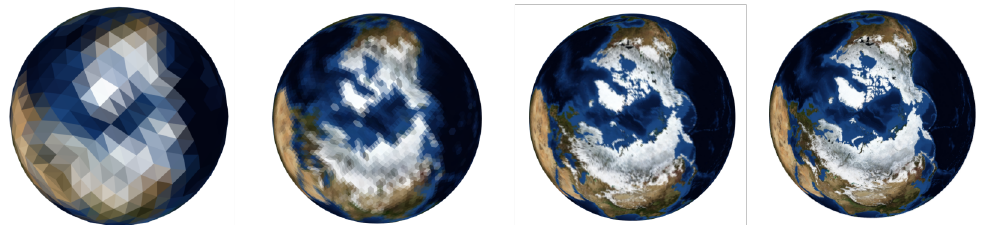
Figure 28. The discrete Earth data visualization based on the octahedron version of global SACs. Resolution level = 4, 6, 8,